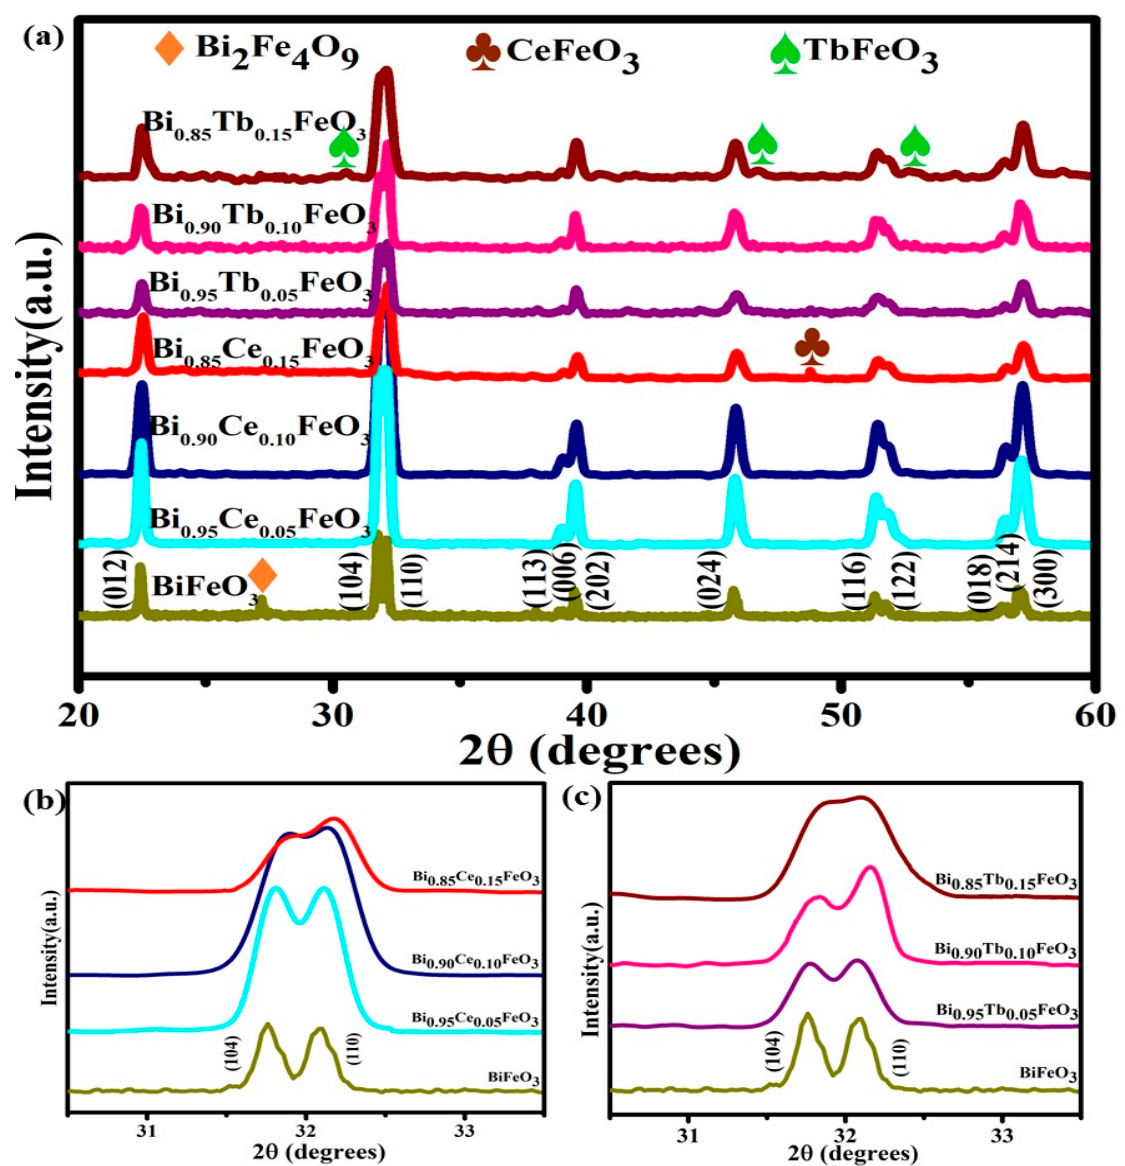
Figure 2. ( a ) XRD patterns of Bi 1 − x R x FeO 3 (R = Ce, Tb; x = 0.00, 0.05, 0.10 and 0.15) samples synthesized at 200 °C. ( b ) Expanded XRD pattern for the BFO: Ce, ( c ) BFO: Tb samples.